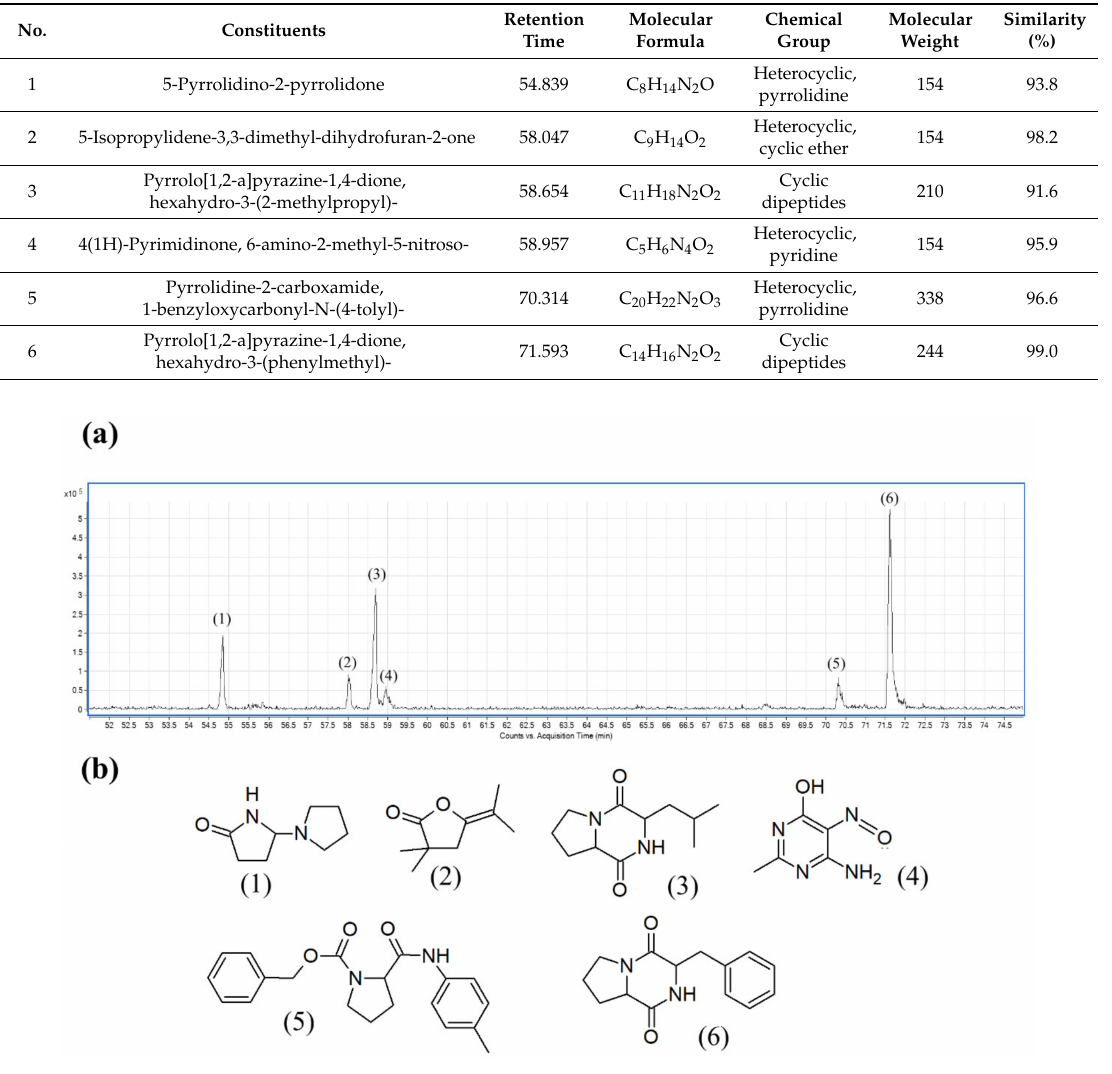
Figure 9. Gas chromatography-mass spectrometry (GC-MS) analysis of MUM256 EA. ( a ) The GC chromatogram of MUM256 EA. ( b ) The chemical structures of the detected constituents present in MUM256 EA. The identification of the chemical compounds was performed by comparing their mass spectra to standard mass spectra available in the database of NIST 05 Spectral